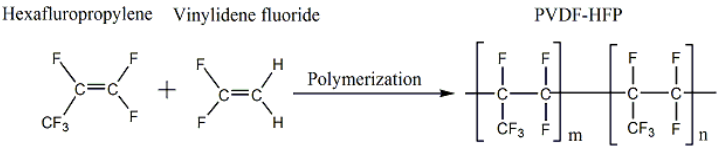
Figure 1. polymerization equation of PVDF-HFP. Figure 1. Polymerization equation of